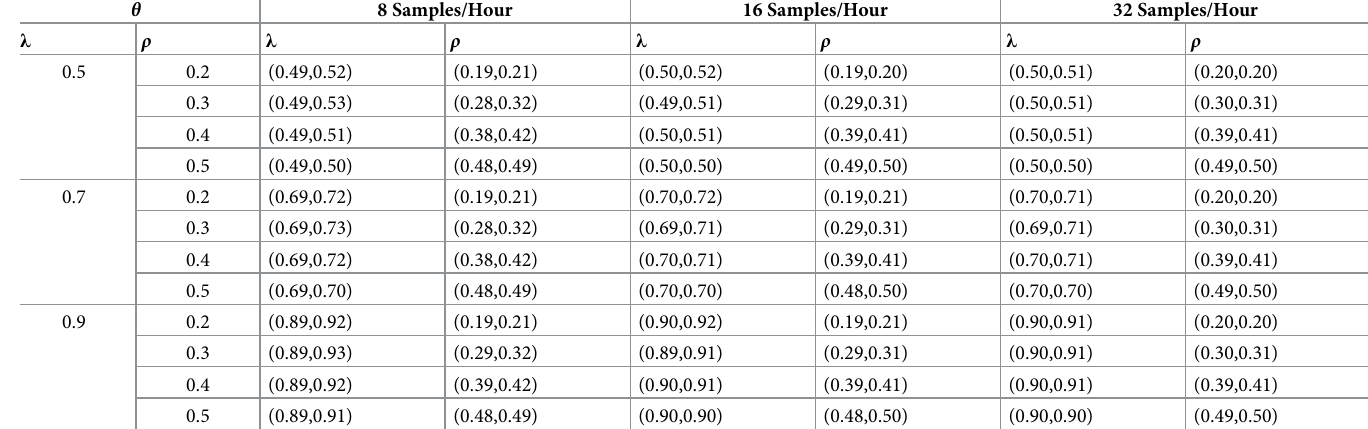
Table 1. Credible intervals (95%) for parameter estimates on simulated data. The table summarizes the parameter inference results for twelve ( λ , ρ ) parameter pairs and three sampling rates using data simulated from the ATP